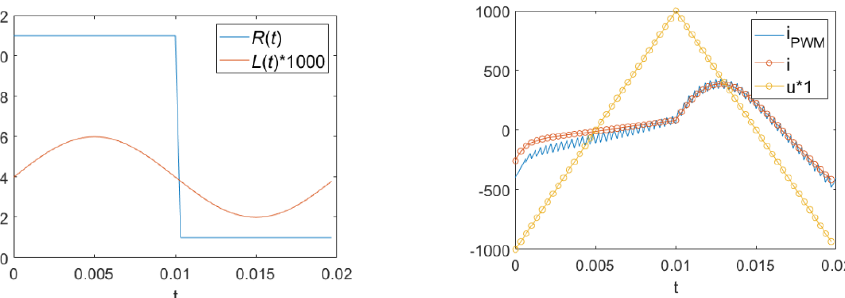
Figure 8. Example waveforms of R ( t ) [ Ω ], L ( t ) [H] and branch voltage u ( t ) [V] current i ( t ) [A] as well as PWM current i PWM for N = 60.